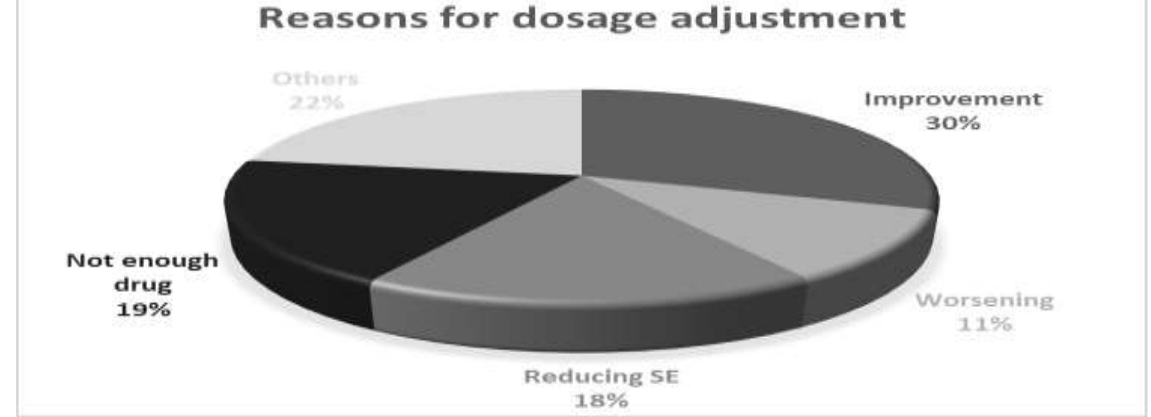
Figure 5. Reasons for dosage